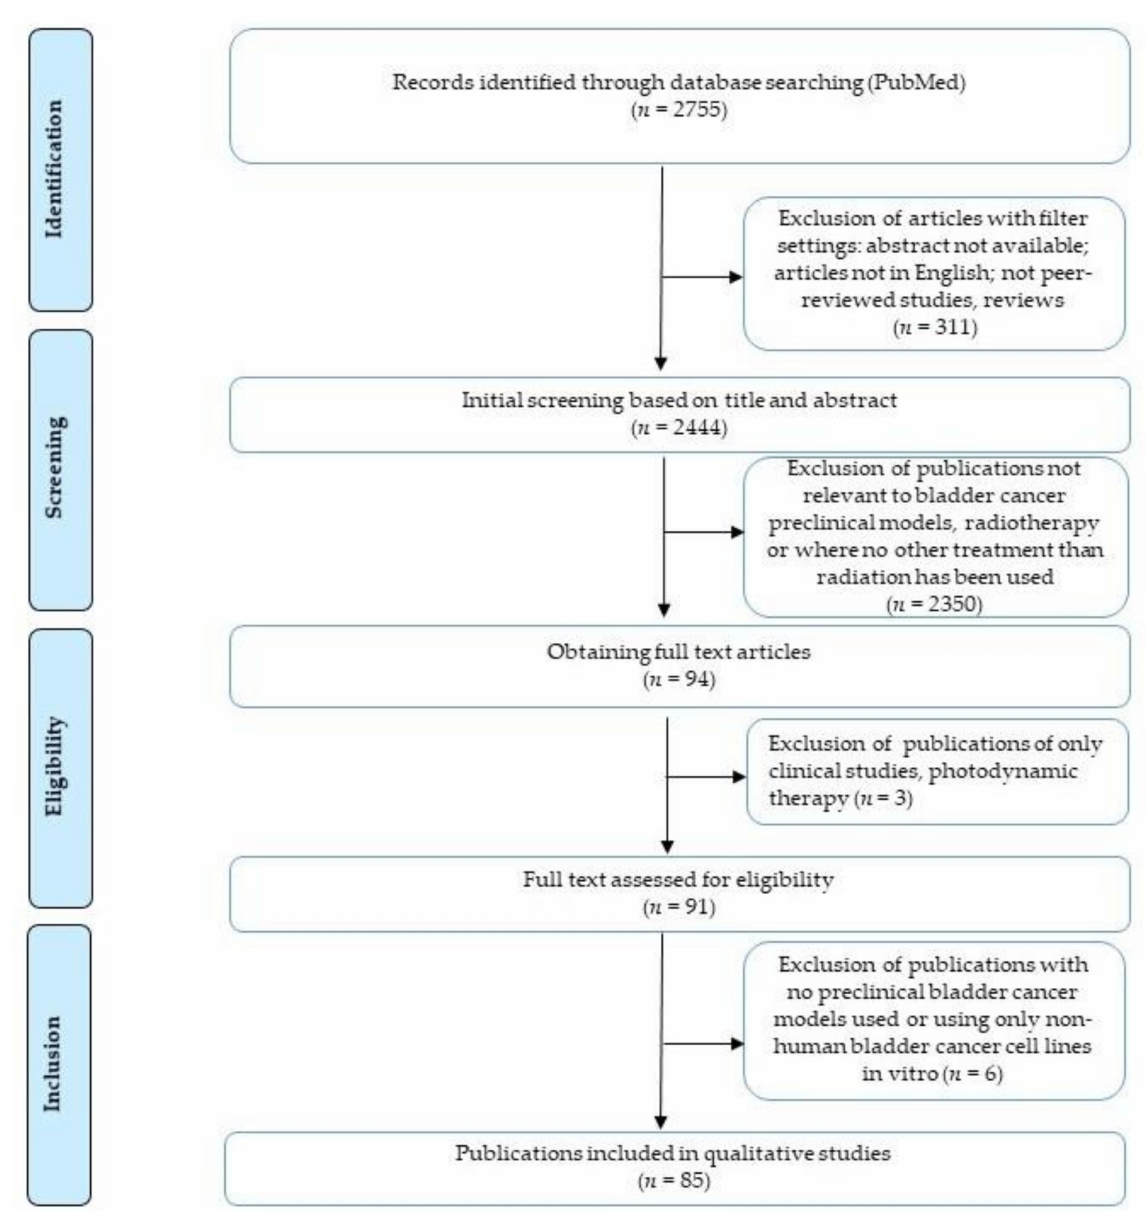
Figure 2. Flow chart showing the identification, screening, evaluation of eligibility and inclusion criteria of